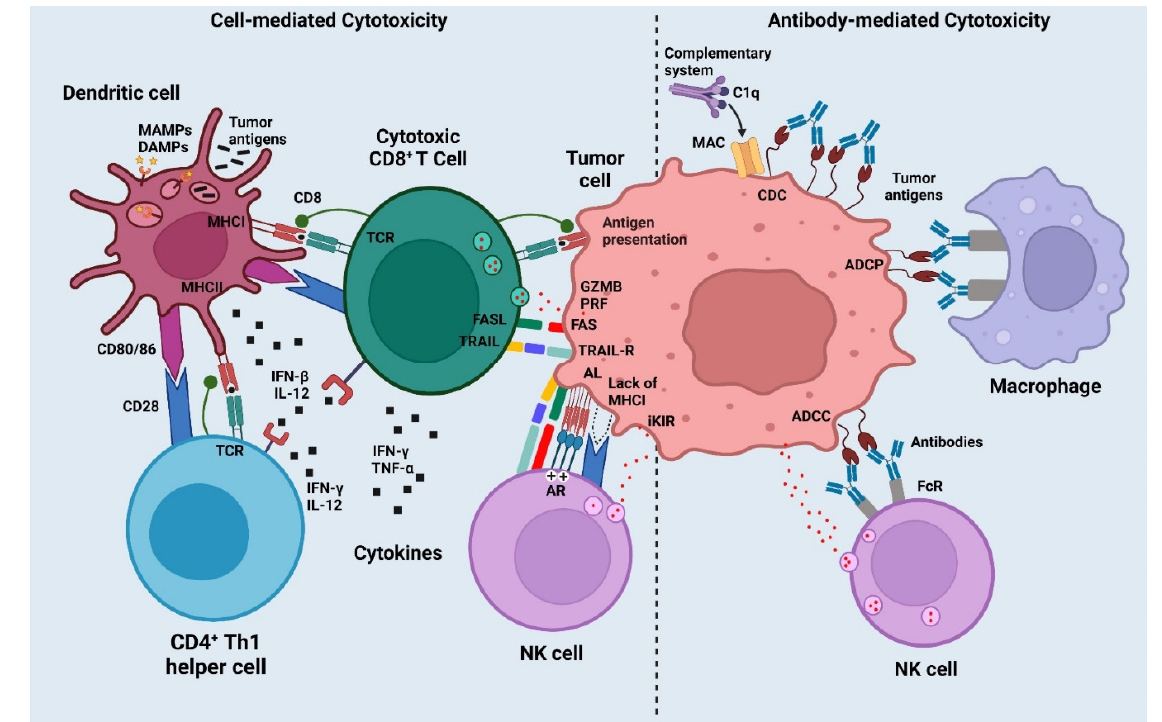
Figure 3 . Mechanism of action of cancer vaccines ( created with biorender . com ). Figure 3. Mechanism of action of cancer vaccines (created with